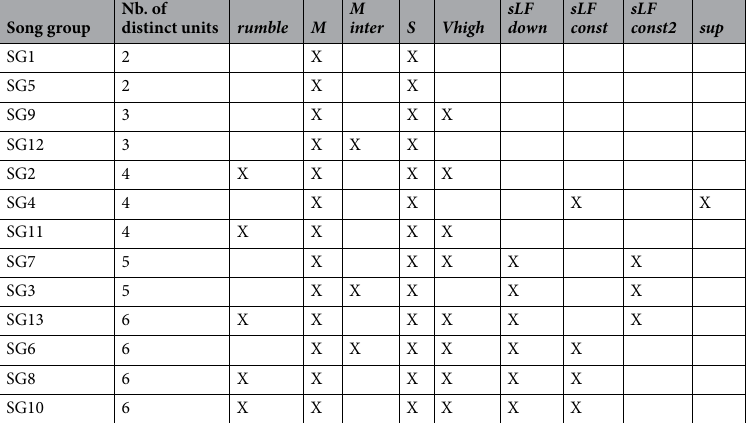
Measurement of unit’s parameters. In order to reduce subjectivity inherent to human observer cat- egorisation, we investigated unit classification and variability using a semi-automated procedure based on unit frequency, modulation and duration measurements. For each song group, all units occurring in a song were assessed for inclusion in further analysis. A unit was selected if it was complete without overlap with other signals. Spectrogram measurements of units comprising the songs were performed in Raven (version 1.5.0, Bioacoustics Research Program 25 ). Some of the measured units displayed biphonation, a nonlinear phenom-